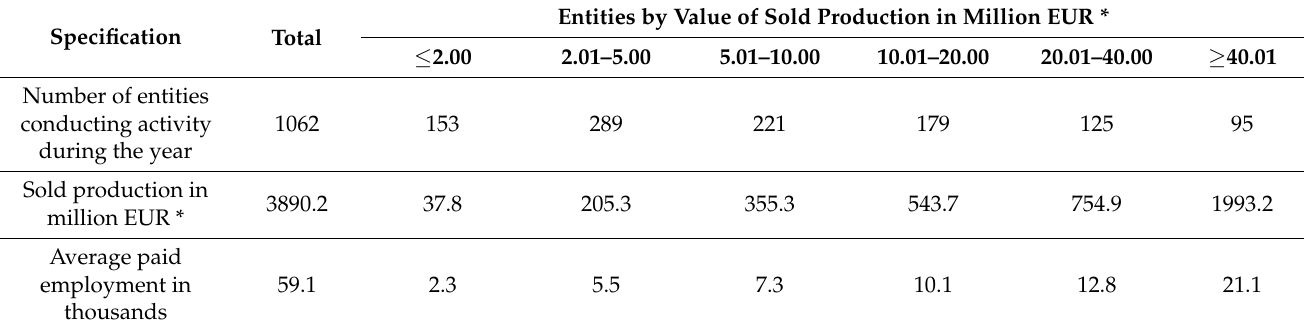
Table 1. Basic data regarding economic entities in the raw material recovery sector in Poland in 2018 (in absolute numbers). Specification